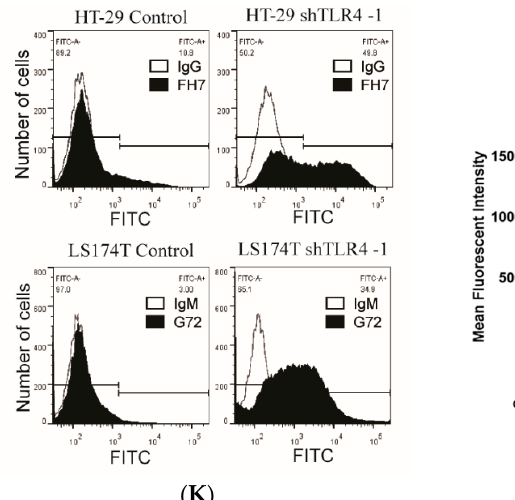
Figure 1. Toll-like receptor 4 (TLR4) mediates the suppression of immunosuppressive Siglec-7 glycan ligands in colorectal cancers. ( A ) Comparison of TLR1–TLR10 amount expression in COAD (Colon adenocarcinoma) and READ (Rectum adenocarcinoma) by Gene Expression Profiling Interactive Analysis (GEPIA2). Gene expression level was calculated by transcript per million (TPM). ( B ) TLR1–TLR10 expression level in normal ( n = 397) and colon cancer samples ( n = 3775) from the GENT2 database. *** p < 0.001. Results are shown as the relative fold increase compared with normal colon control. ( C ) Gene expression analysis of TLR4 in human colon cancer cells (Ca) and non-malignant colonic epithelial cells (N) prepared from same patients ( n = 10). ** p < 0.01. ( D ) Gene expression analysis of TLR2 or TLR4 in normal intestinal cells (HIEC6), DLD-1, HT29, and LS174T cells. ( E ) Gene expression analysis of TLR2 in DLD1 and LS174T after the introduction of shRNAs for TLR2. ( F ) Gene expression analysis of TLR4 in HT-29 and LS174T after the administration of shRNAs for TLR4. ( G ) SLC26A2 expression in colon cancer cells after the administration of shRNAs for TLR2 and TLR4. ( H ) ST6GalNAc6 expression in colon cancer cells after the administration of shRNAs for TLR2 and TLR4. ( I ) Flow cytometry analysis of expression of disialyl Lewis a (top panels) and sialyl 6- sulfo Lewis x (bottom panels) on DLD-1 and LS174T cells, respectively, after the administration of shRNAs for TLR2. ( J ) Fluorescence intensity results of flow cytometry analysis in ( I ) are shown. The relative expression levels of disialyl Lewis a stained with FH7 antibody or sialyl 6-sulfo Lewis x stained with G72 antibody are shown as mean fluorescence intensity (MFI) compared with the staining of control IgG or IgM. *** p < 0.001. ( K ) Flow cytometry analysis of expression of disialyl Lewis a (top panels, FH7) or sialyl 6- sulfo Lewis x (bottom panels, G72) on HT-29 or LS174T cells, respectively, after the administration of shRNAs for TLR4. ( L ) Fluorescence intensity results of flow cytometry analysis in ( K ) are shown. The relative expression levels of disialyl Lewis a and sialyl 6-sulfo Lewis x are shown as mean fluorescence intensity (MFI) compared with the staining of control IgG or IgM. *** p < 0.001.